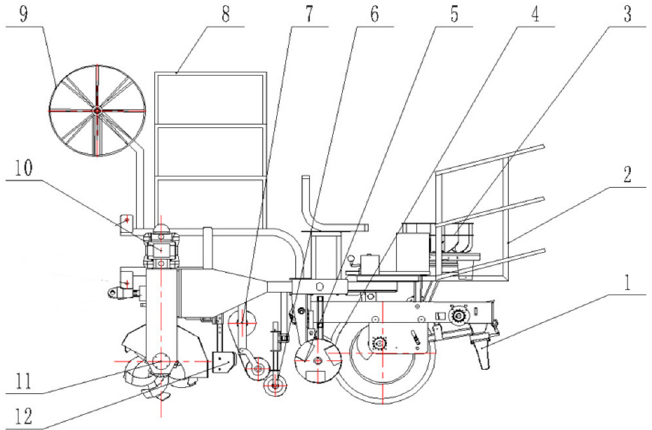
Figure 1. Dryland Cantaloupe Transplanter Under water. 1. Duck-billed transplanting apparatus; 2. The front of the seedling plate; 3. Cylinder seedling cup feeding mechanism; 4. gearset; 5. Cooling mechanism; 6.Pressure film mechanism;7.Membrane overlying mechanism ;8.Behind the seedling plate; 9.Pipe laying parts ;10.Sitting water system; 11.Rotary tillage parts; 12.Open ditch parts.